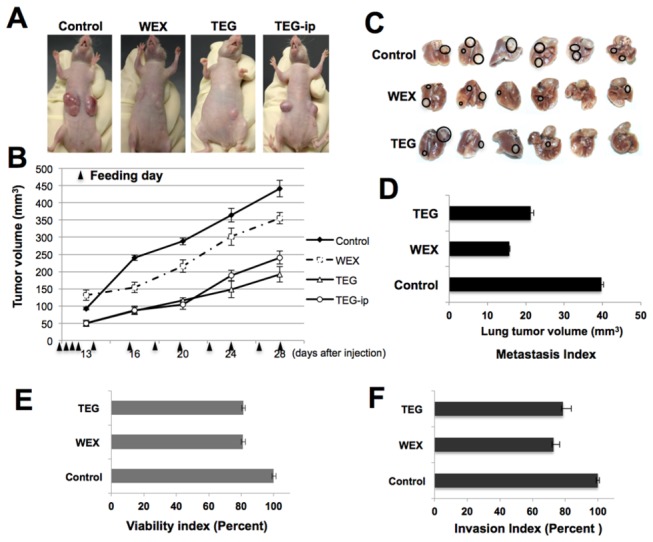
Anticancer activity of TEG in in
vivo assays.(A-B) Anticancer activity of TEG was examined in nude mice tumor formation assay using HT1080 cells in subcutaneous xenografts and lung metastasis. Both, oral feeding and intraperitoneal injection of TEG, showed suppression in the tumor growth. (C) Lung metastasis was significantly reduced in nude mice fed with WEX (ASH-WEX) as well as TEG (C and D). In
vitro viability and Matrigel Invasion assays on HT1080 cells revealed the reduction in viability as well as invasion capacity (E and F).